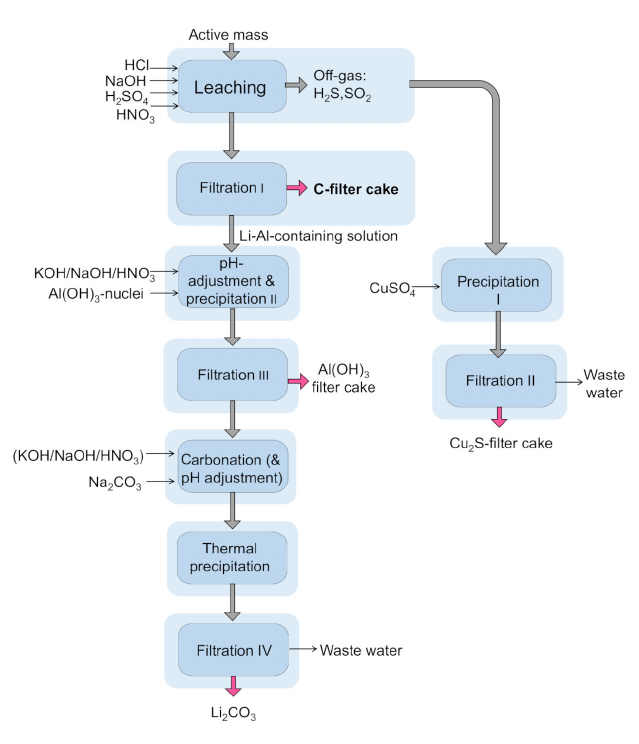
Figure 4. Proposed process flow chart for a hydrometallurgical treatment of lithium–sulfur